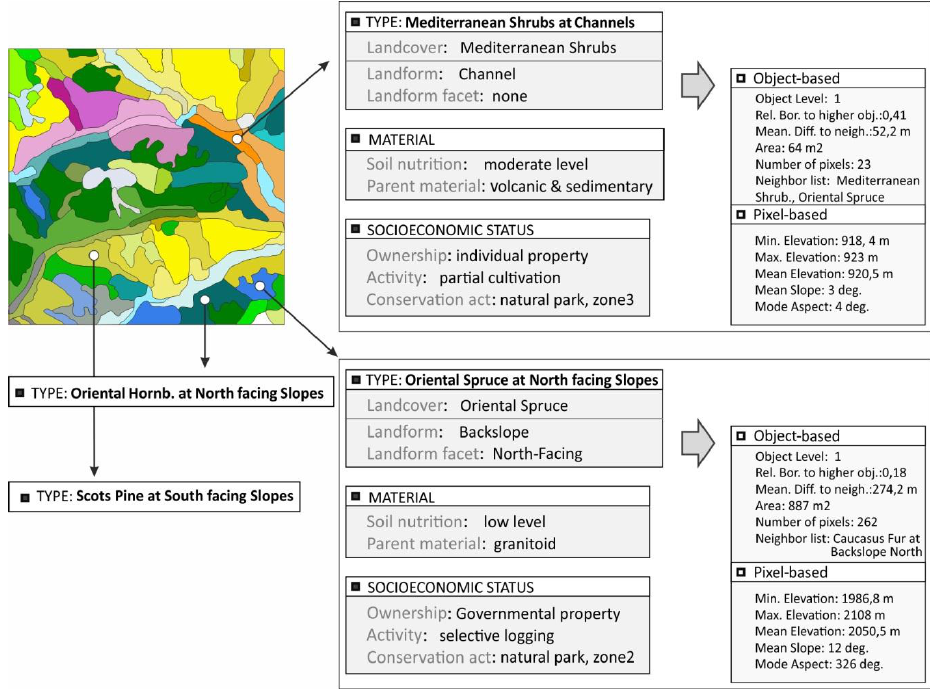
Figure 10. Four LMU records, two of which are appended for their attributes at class, object and pixel levels from the geodatabase of LMUs.